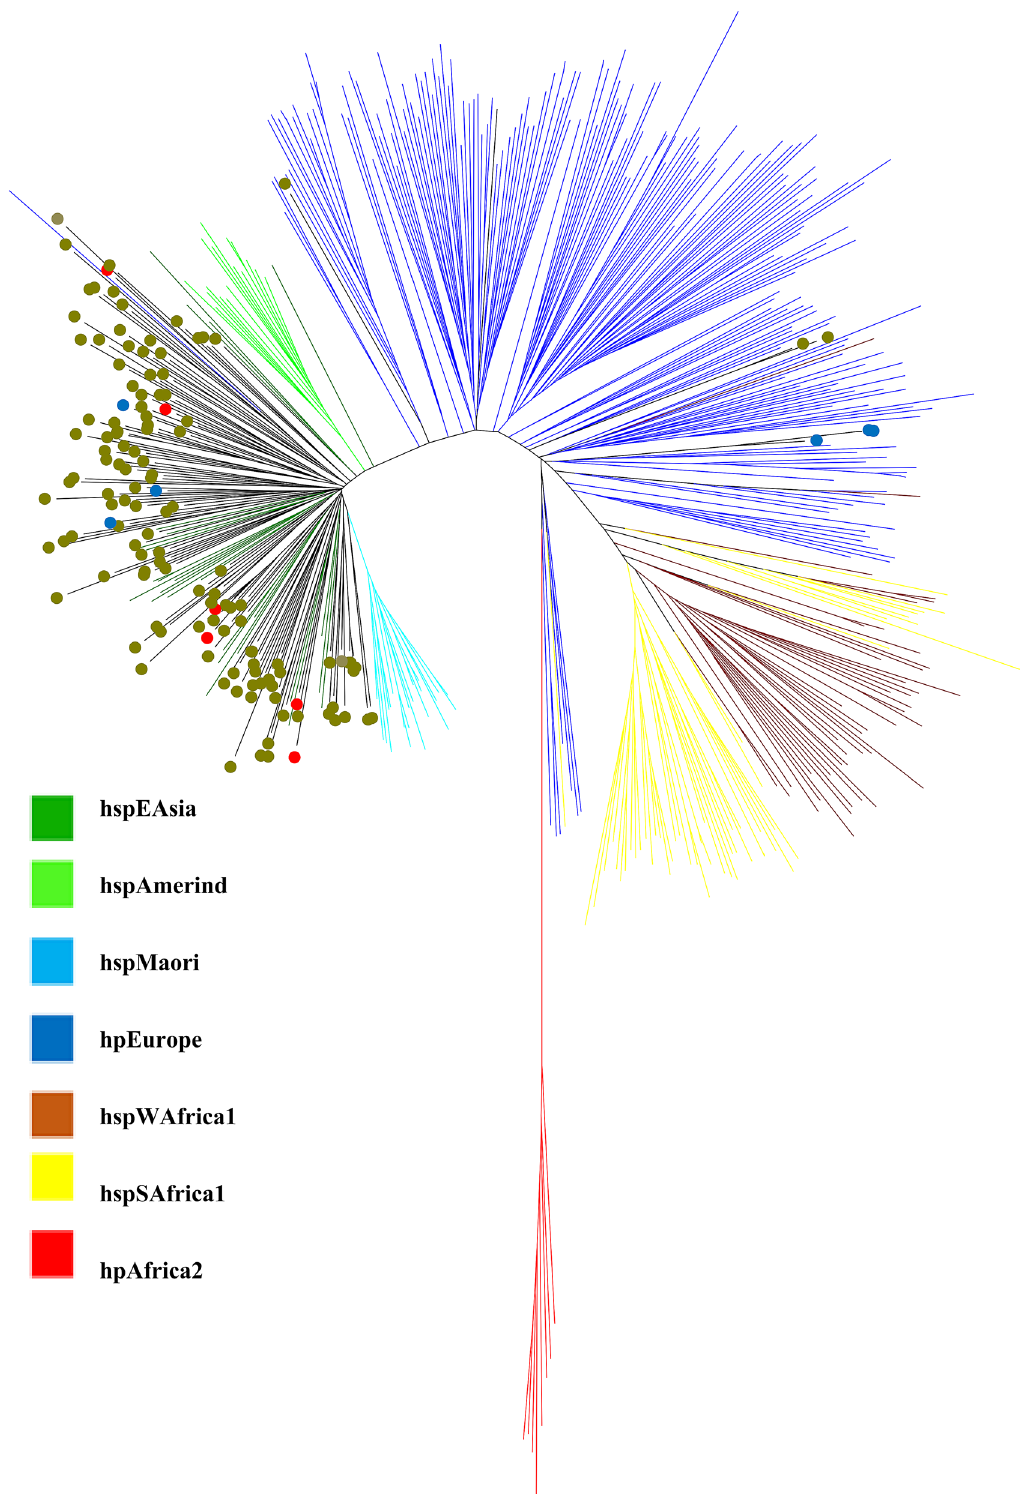
Figure 3. A phylogenetic tree was constructed through the concatenation of seven housekeeping genes from 136 Vietnam strains (olive circle) and 379 reference strains from PubMLST (http://pubml st.org/helic obact er/). The circle indicates our studied strains: blue ( cagA -negative), red (Western-type cagA), and olive (East Asian- type cagA